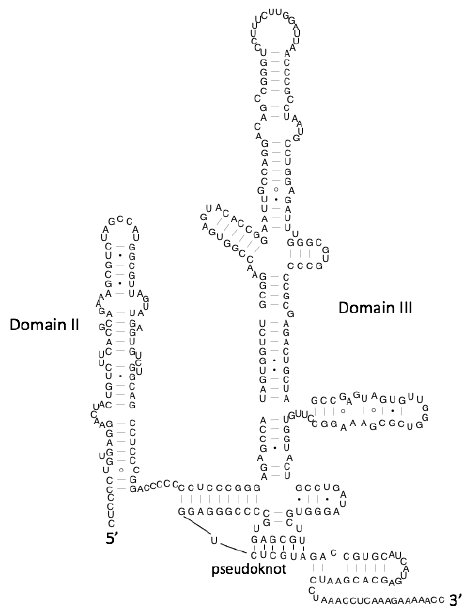
Figure 5. Structure of the HCV IRES. The two major domains, II and III, are highlighted, alongside the pseudoknot.